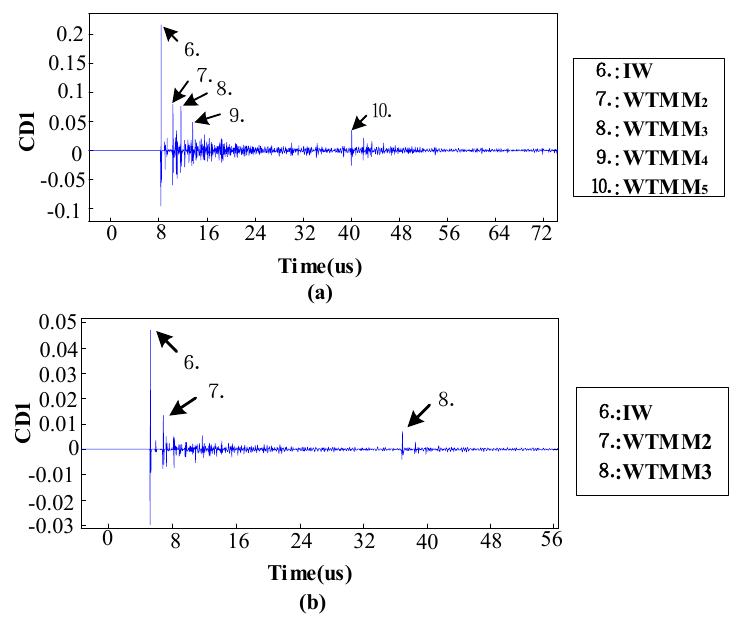
Figure 15. The CD1 component of aerial-mode voltage of Figure 14. ( a ) The CD1 at measurement unit 2; ( b ) The CD1 at measurement unit 3.